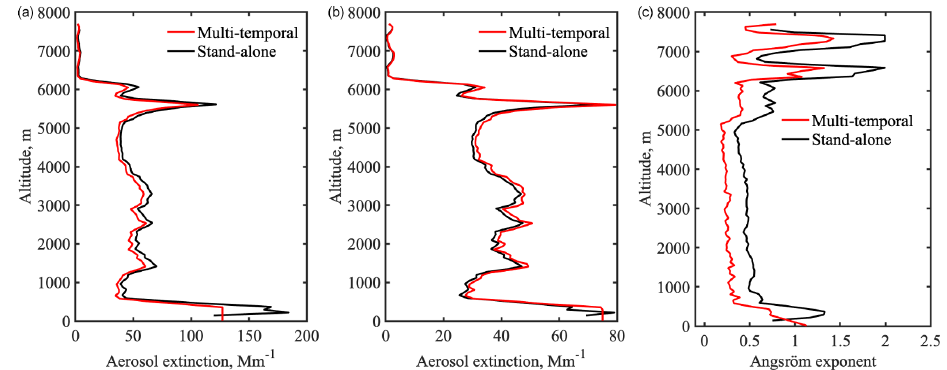
Figure 25. Aerosol extinction profiles at 455nm (a) and 940nm (b) and corresponding Ångström exponent (c) estimated from COBALD profiles acquired on 11 August 2015 using a stand-alone (black) and multi-temporal (red) retrieval schemes.